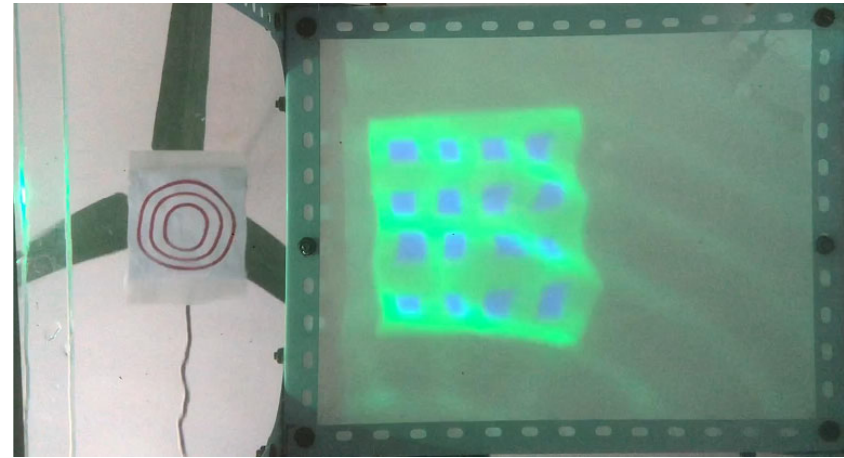
Figure 11. A real scene image captured by the camera.